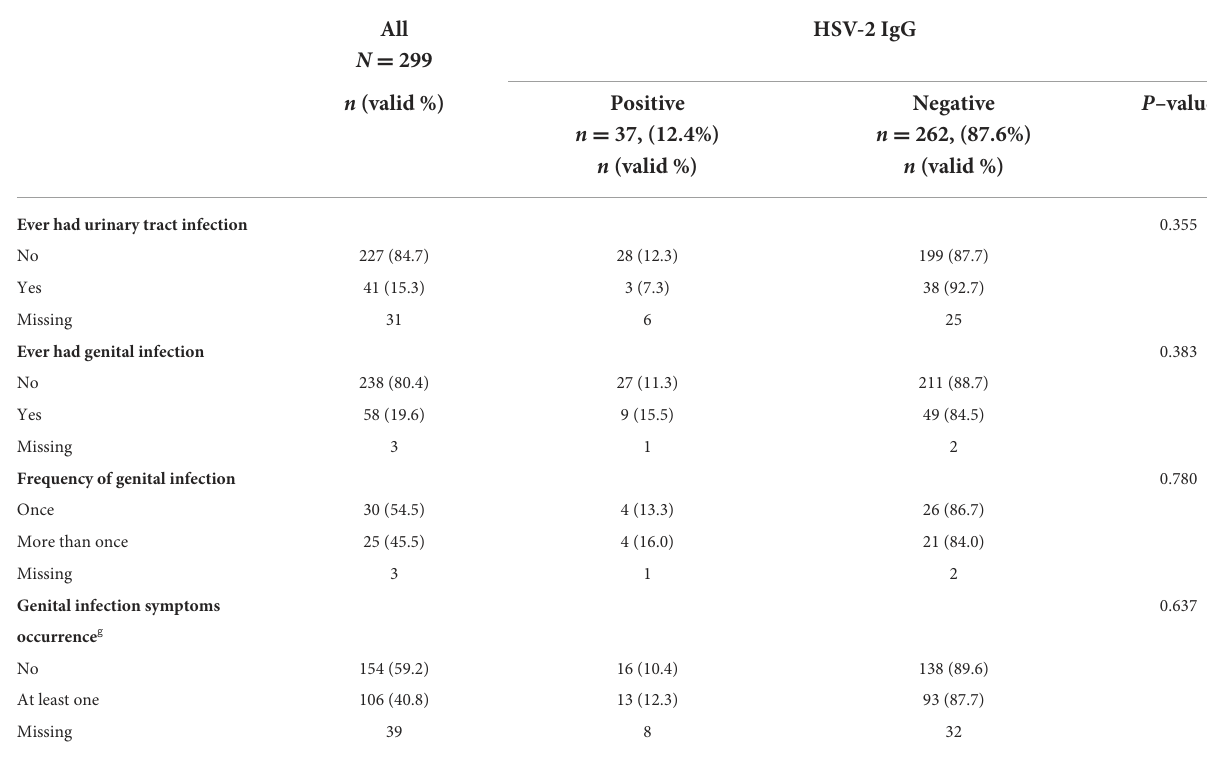
c Cardiovasculardisordersofanytypeincludinghighbloodpressure. d